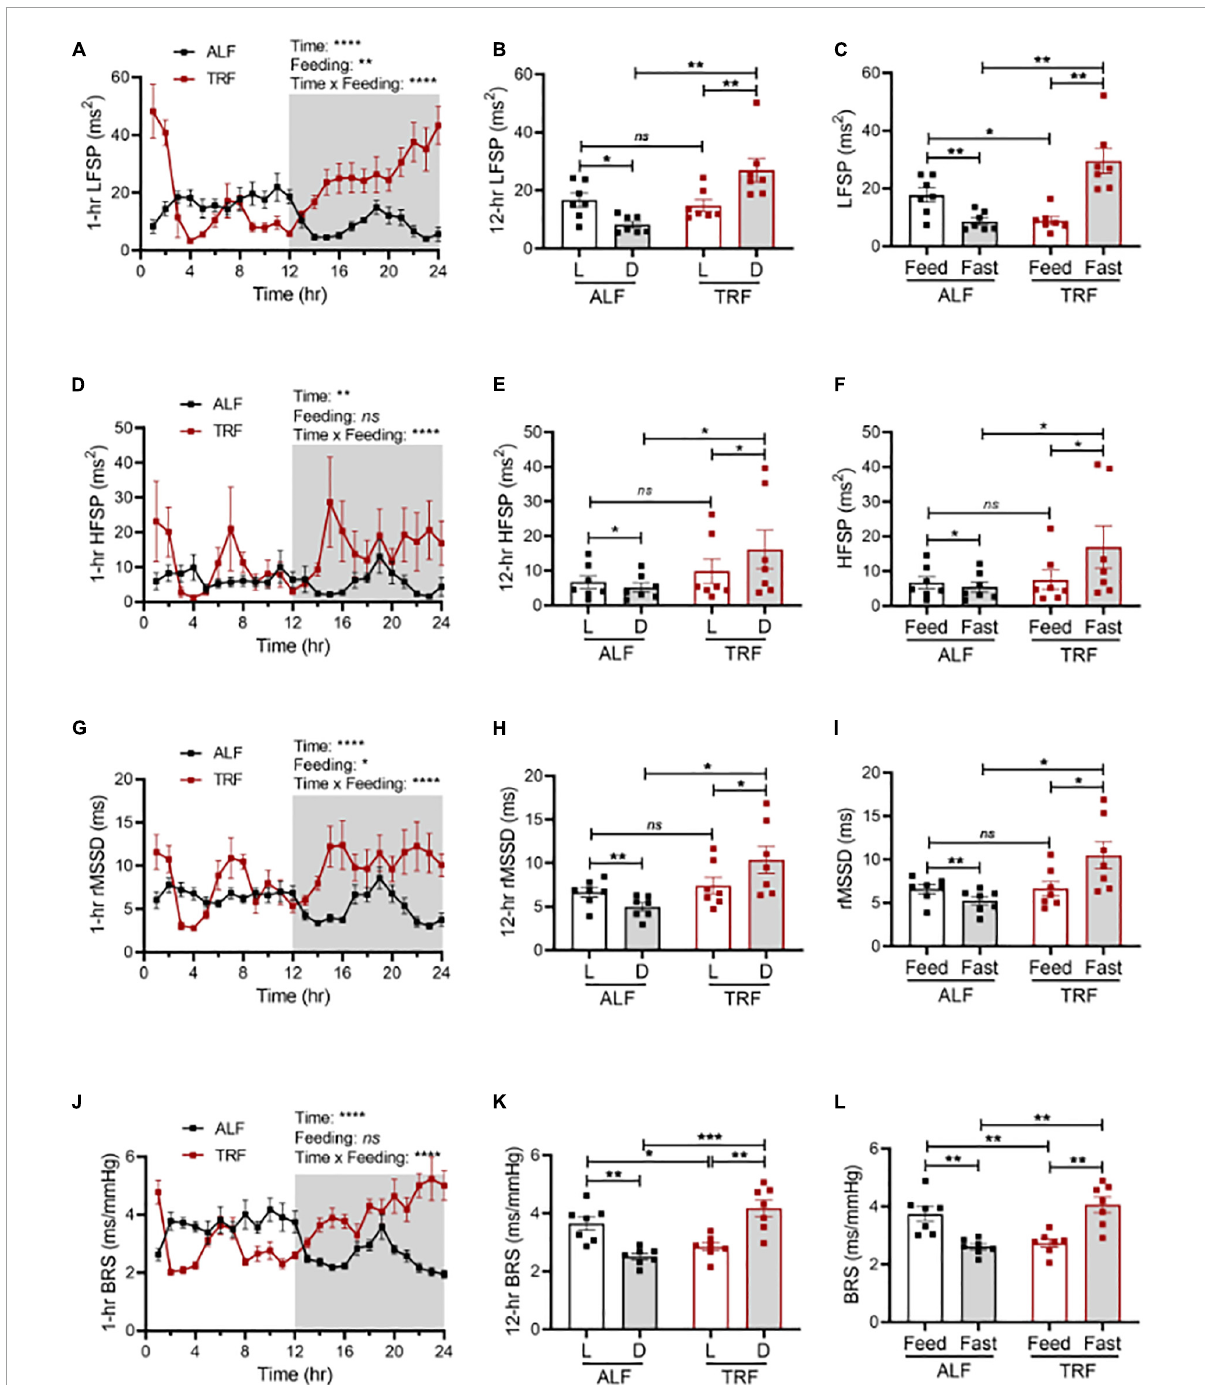
FIGURE4 Light-phase TRF modulates autonomic nervous activity. Heart rate variability and cardiac baroreflex sensitivity (BRS) were calculated from BP data recorded 3 days under ALF and the last 3 days of TRF. N = 7. (A,B) Low-frequency spectral power (LFSP) in 1-h (A) and 12-h (B) intervals. (C) LFSP during feeding and fasting period. (D,E) High-frequency spectral power (HFSP) in 1-h (D) and 12-h (E) intervals. (F) HFSP during feeding and fasting period. (G,H) Root mean square of successive differences between normal heartbeats (rMSSD) in 1-h (G) and 12-h (H) intervals. (I) The rMSSD during the feeding and fasting period. (J,K) BRS in 1-h (J) and 12-h (K) intervals. (L) BRS during feeding and fasting period. Data were expressed as the mean ± SEM and analyzed by repeated two-way ANOVA with matching conditions between light vs. dark phase or feed vs. fast and between ALF vs. light-phase TRF with Tucky’s post–hoc analysis (A–L) . * P < 0.05; ** P < 0.01; *** P < 0.001; **** P < 0.0001; ns, not